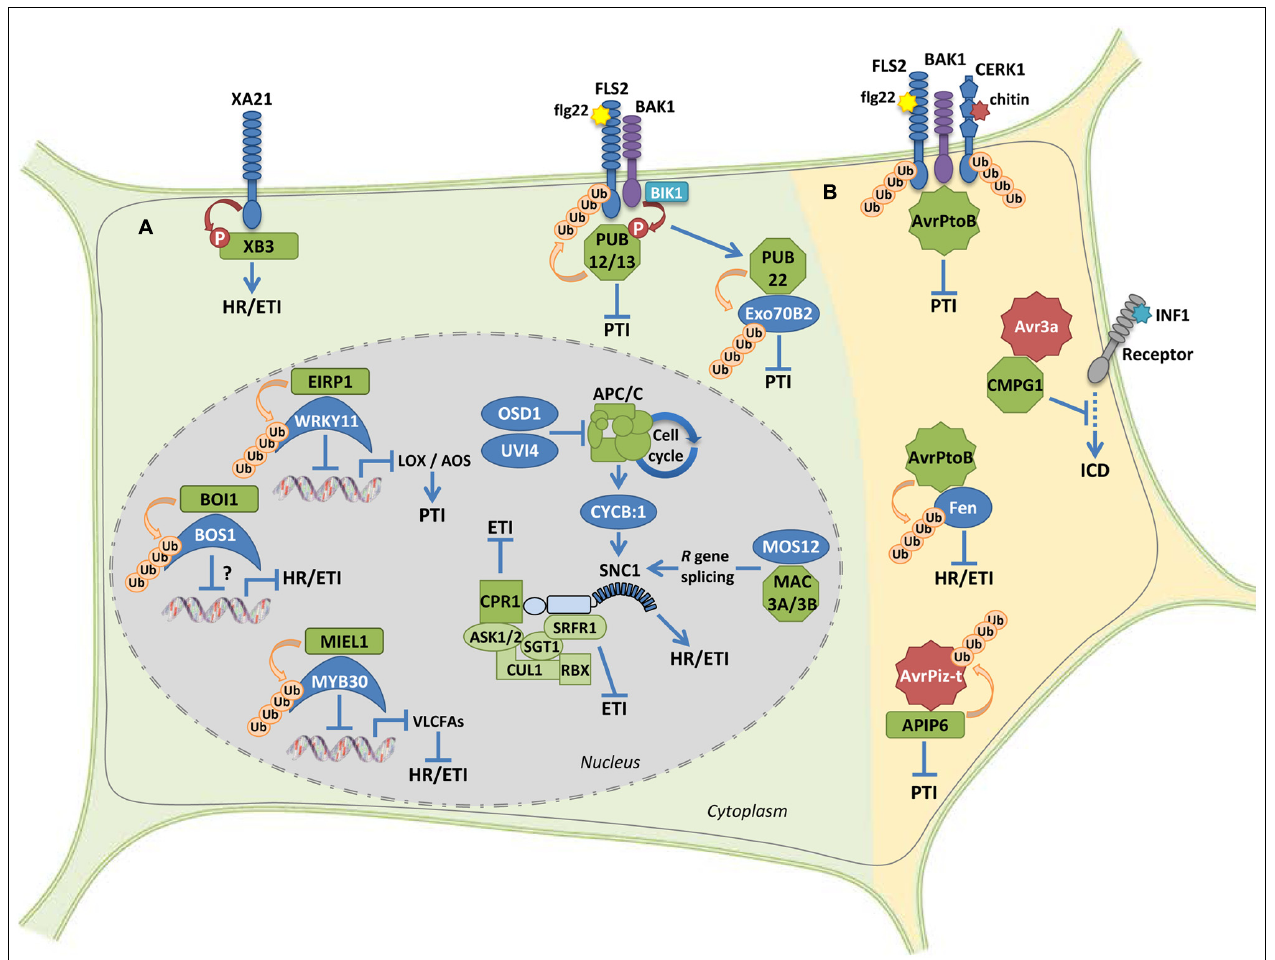
transcriptional activation of VLCFA-related genes and therefore suppressed HR and defense responses. The RING protein BOI1 interacts with and ubiquitinates the MYB TF BOS1 that is required for pathogen resistance. However, the effect of BOI1 on BOS1 accumulation and transcriptional activation remains unknown. (B) Microbial effector proteins acting as or interacting with E3 ligase proteins in the host. The bacterial effector AvrPtoB is able to suppress both PTI and ETI signaling though its respective interaction with FLS2/CERK1 PRRs and the cytoplasmic kinase Fen. The oomycete effector AVR3a suppresses INF1-induced cell death by interacting with and stabilizing the host U-box E3 ligase CMPG1. The fungal effector protein AvrPiz-t targets the RING E3 ligase APIP6, which in turn is able to ubiquitinate AvrPiz-t, resulting in suppressed PTI. RING-, F-box- and U-box-type E3 Ub-ligases are, respectively, represented by rectangles, squares, and octagons. All proteins displaying E3 ligase activity are represented in green. Effectors are represented by stars. See the text for